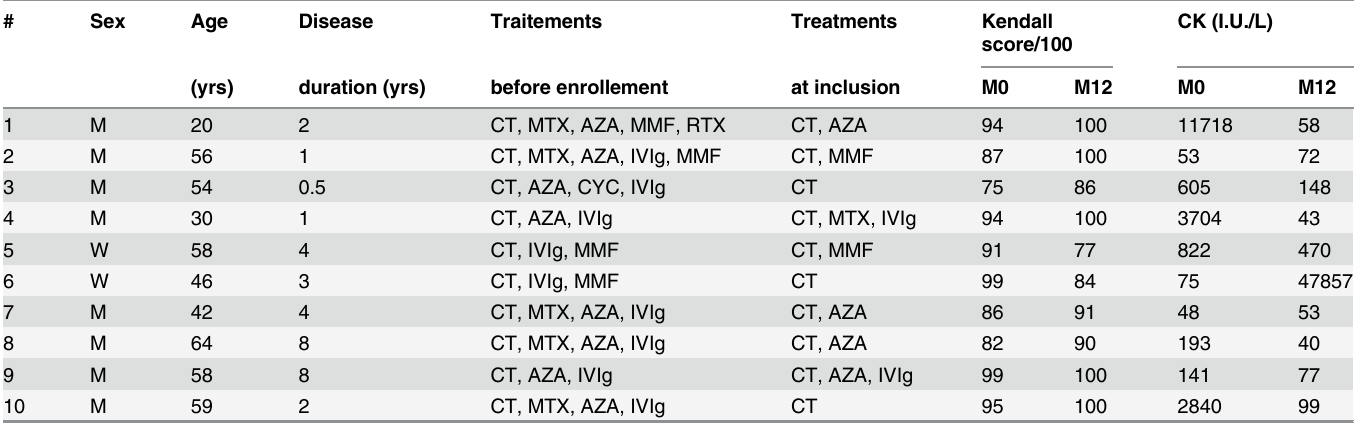
Table 1. Patients characteristics, muscular evaluation, and treatment administration at baseline and month